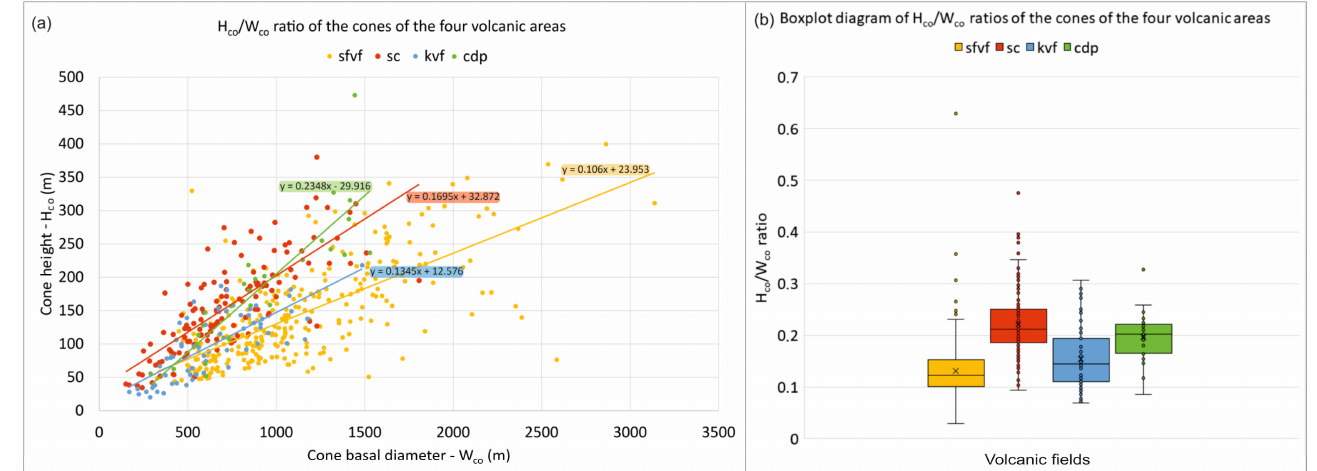
Figure 4. ( a ) H co / W co ratio, ( b ) boxplot diagram of H co / W co ratios of the four volcanic areas (yel- low: San Francisco, red: Chichinautzin, blue: Kula, green: CdP).